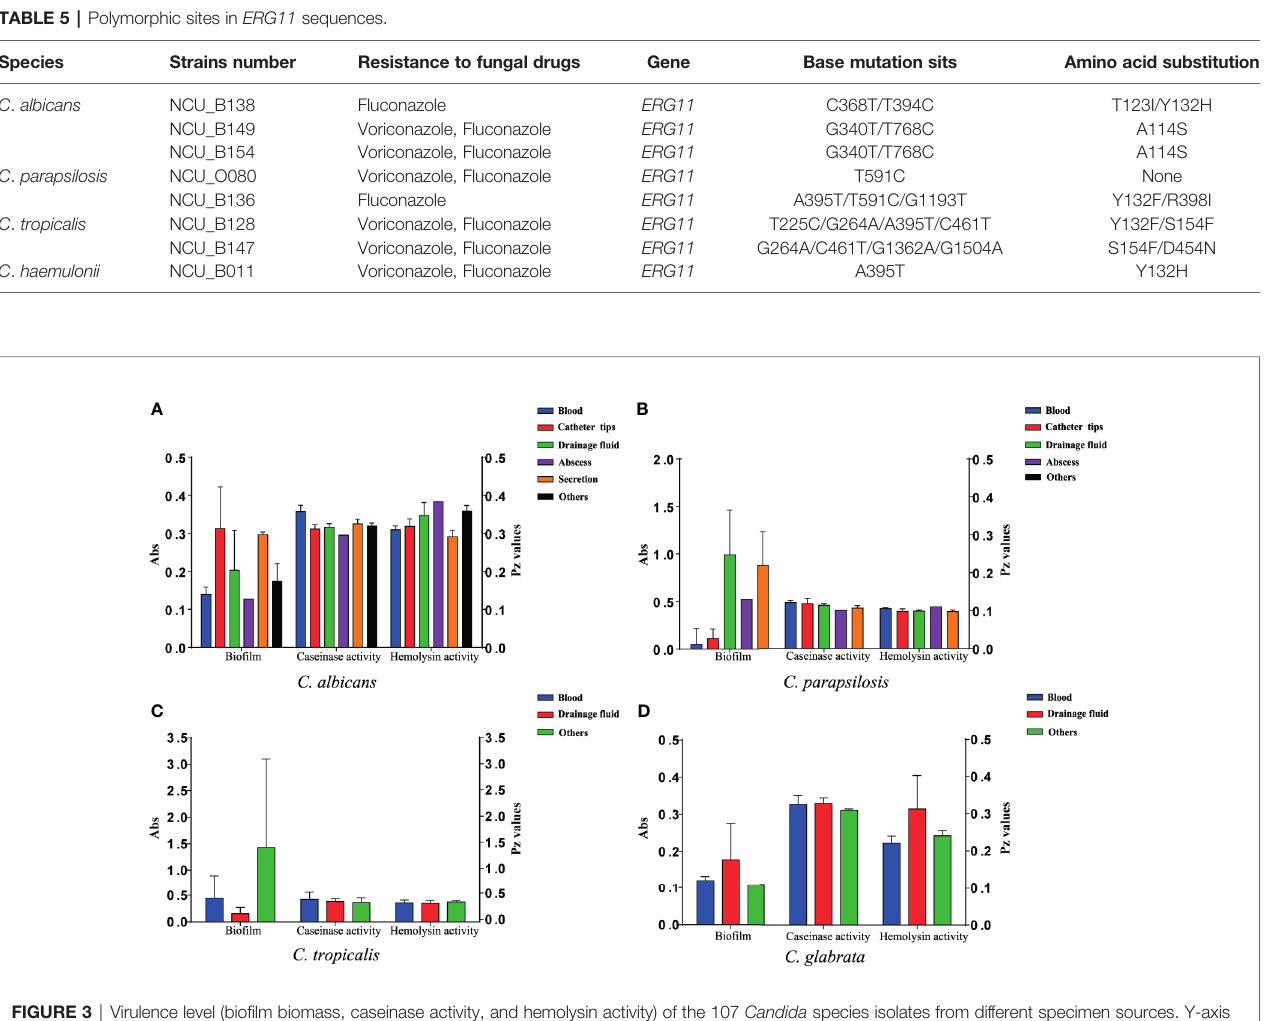
FIGURE 3 | Virulence level (bio fi lm biomass, caseinase activity, and hemolysin activity) of the 107 Candida species isolates from different specimen sources. Y-axis (far left panel): bio fi lm biomass (positively correlated with virulence); Y-axis (far right panel): the Pz values of caseinase and hemolysin activities (negatively correlated with virulence). No signi fi cant differences were noted in these factors. (A) The virulence level of 40 C. albicans isolates from different specimen sources. (B) The virulence level of 37 C. parapsilosis isolates from different specimen sources. (C) The virulence level of 21 C. tropicalis isolates from different specimen sources. (D) The virulence level of 9 C. glabrata isolates from different specimen